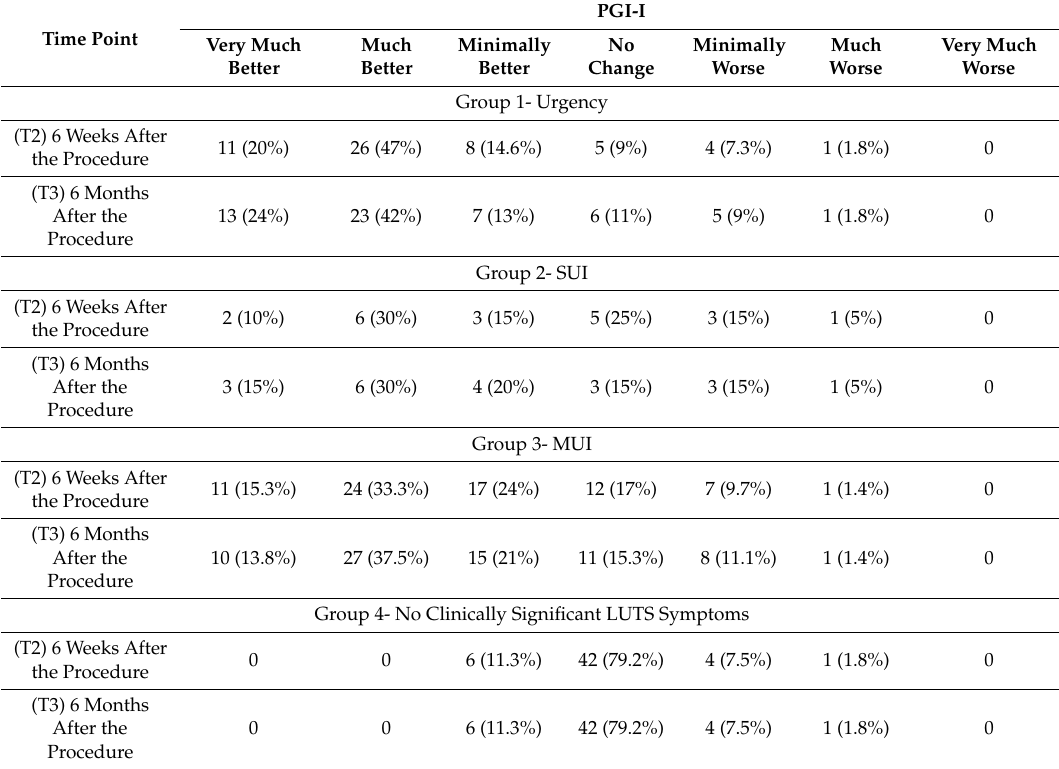
Table 3. Patient Global Impression of Improvement (PGI-I) results in study groups.